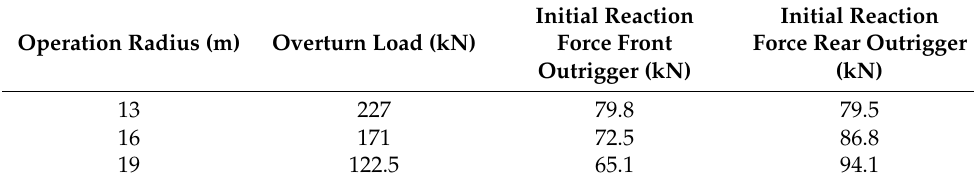
Table 2. Analyzed results of outrigger reaction forces.